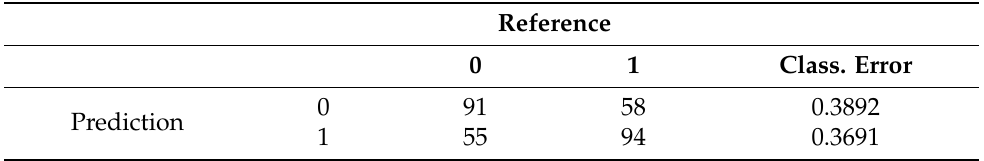
Table 8. Confusion matrix of the RF classifier.